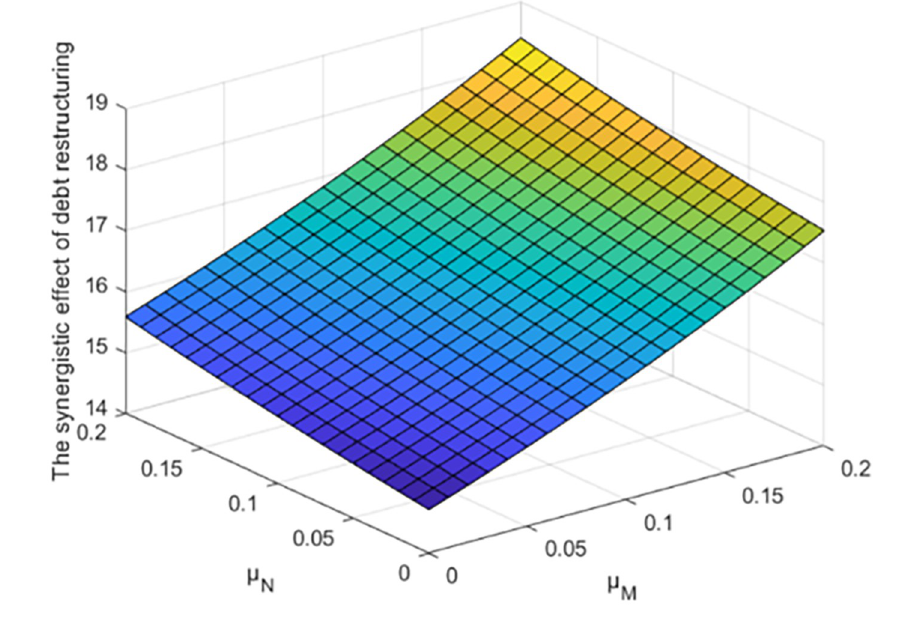
and μ on the synergistic effect of debt restructuring. M N